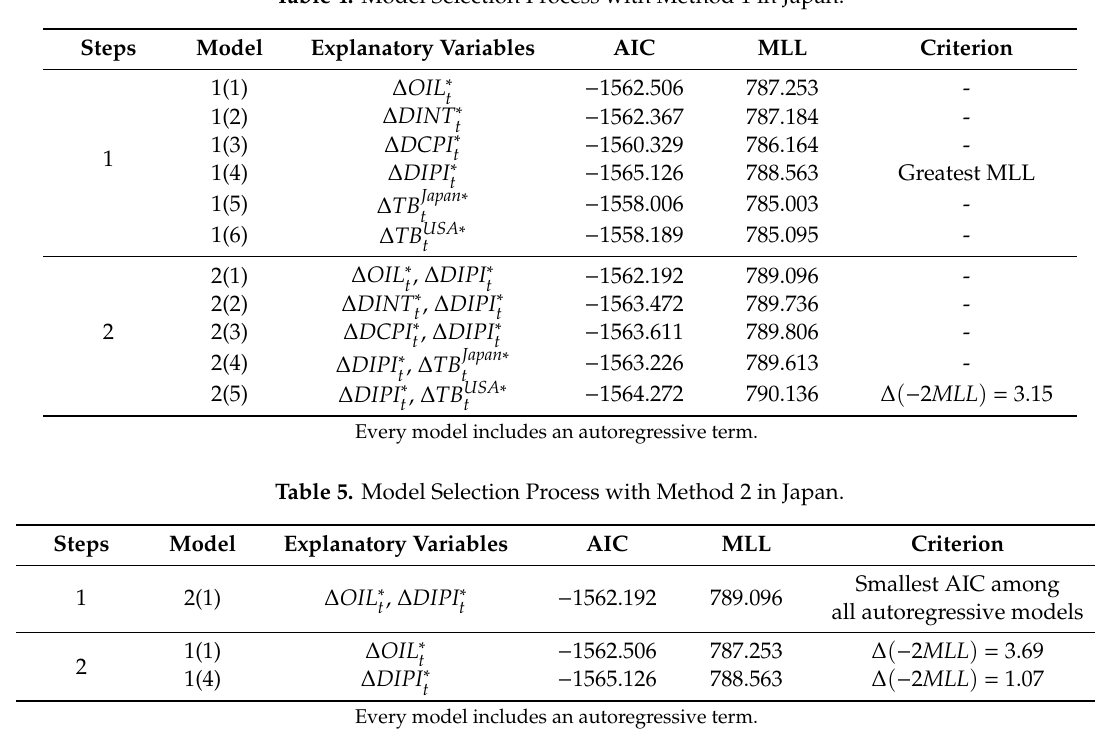
Table 4. Model Selection Process with Method 1 in Japan.